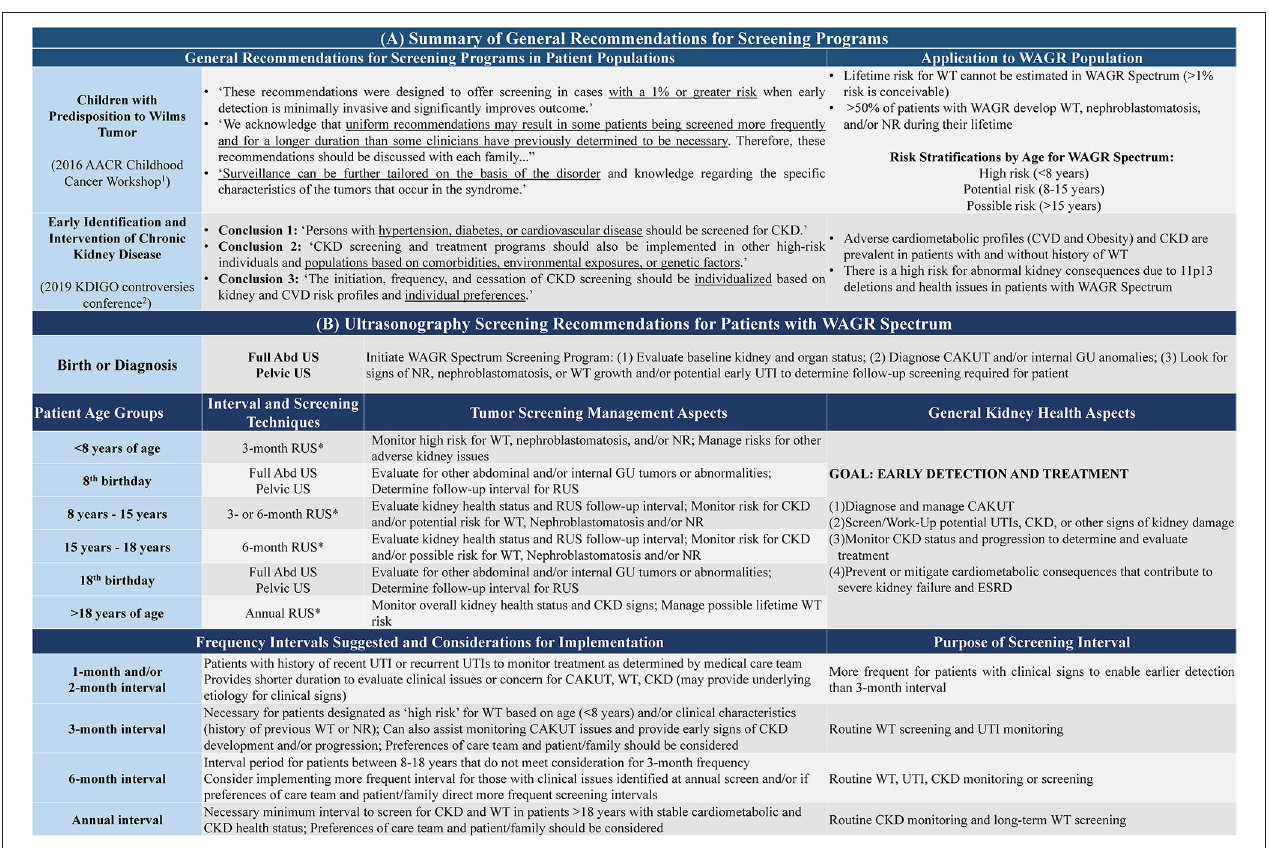
FIGURE 6 | The WAGR spectrum screening program. All patients with WAGR Spectrum should receive routine renal ultrasonography (RUS) to monitor for kidney health throughout their lifetime. The principles underlying the recommendations developed for monitoring Wilms Tumor (WT) and Chronic Kidney Disease (CKD) with application to patients with WAGR are described in (A) ; recommendation groups included the 1 American Association for Childhood Cancer Research recommendations (3) and 2 Kidney Disease: Improving Global Outcomes (KDIGO) Work Group (39). (B) Provides recommendations for the age groups and suggestions for specific interval periods that could be applied for the RUS screening program. These intervals are based on the patient’s age and potential risk—below the age of 8 years, all patients should be considered at risk for WT development and receive appropriate monitoring through RUS every 3 months (*unless more frequent indicated by detection or suspicion for renal abnormality). After the age of 8 years, consideration for frequency of follow-up should be determined in combination with clinical history, current status, and discussion between care team and patient/family to determine the best individualized course. All patients should at least receive annual RUS to monitor for CKD risk. Additional imaging such as full abdominal U/S and pelvic U/S are warranted at certain periods as the patient ages to monitor the status of other internal organs and GU